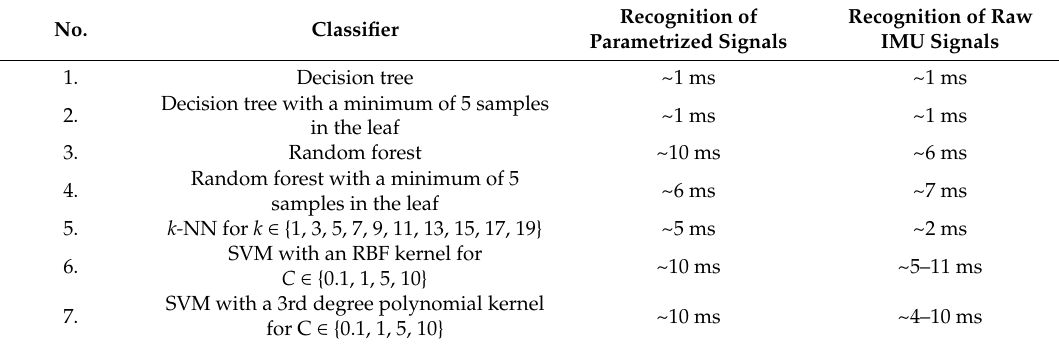
Table 8. Recognition times of a gesture for a single input data